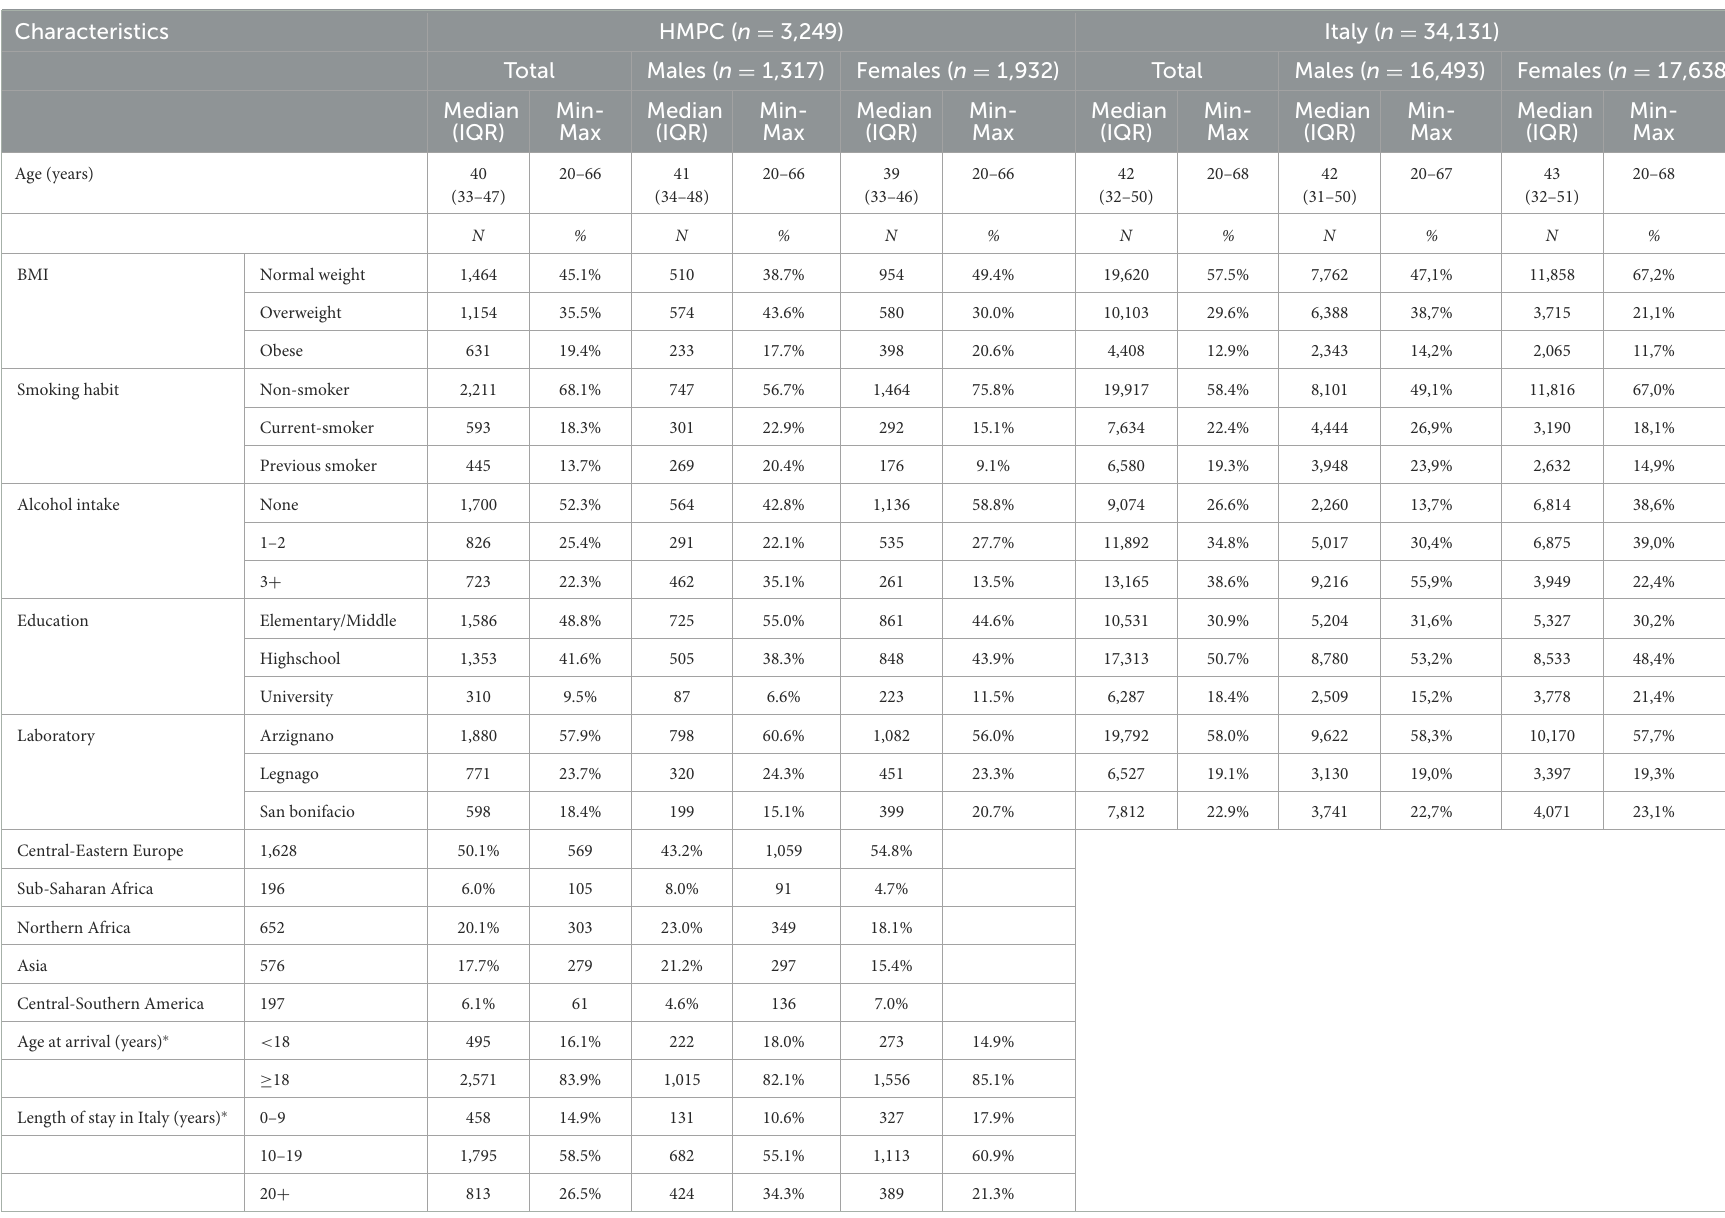
TABLE 1 Characteristics of the included subjects by immigrant